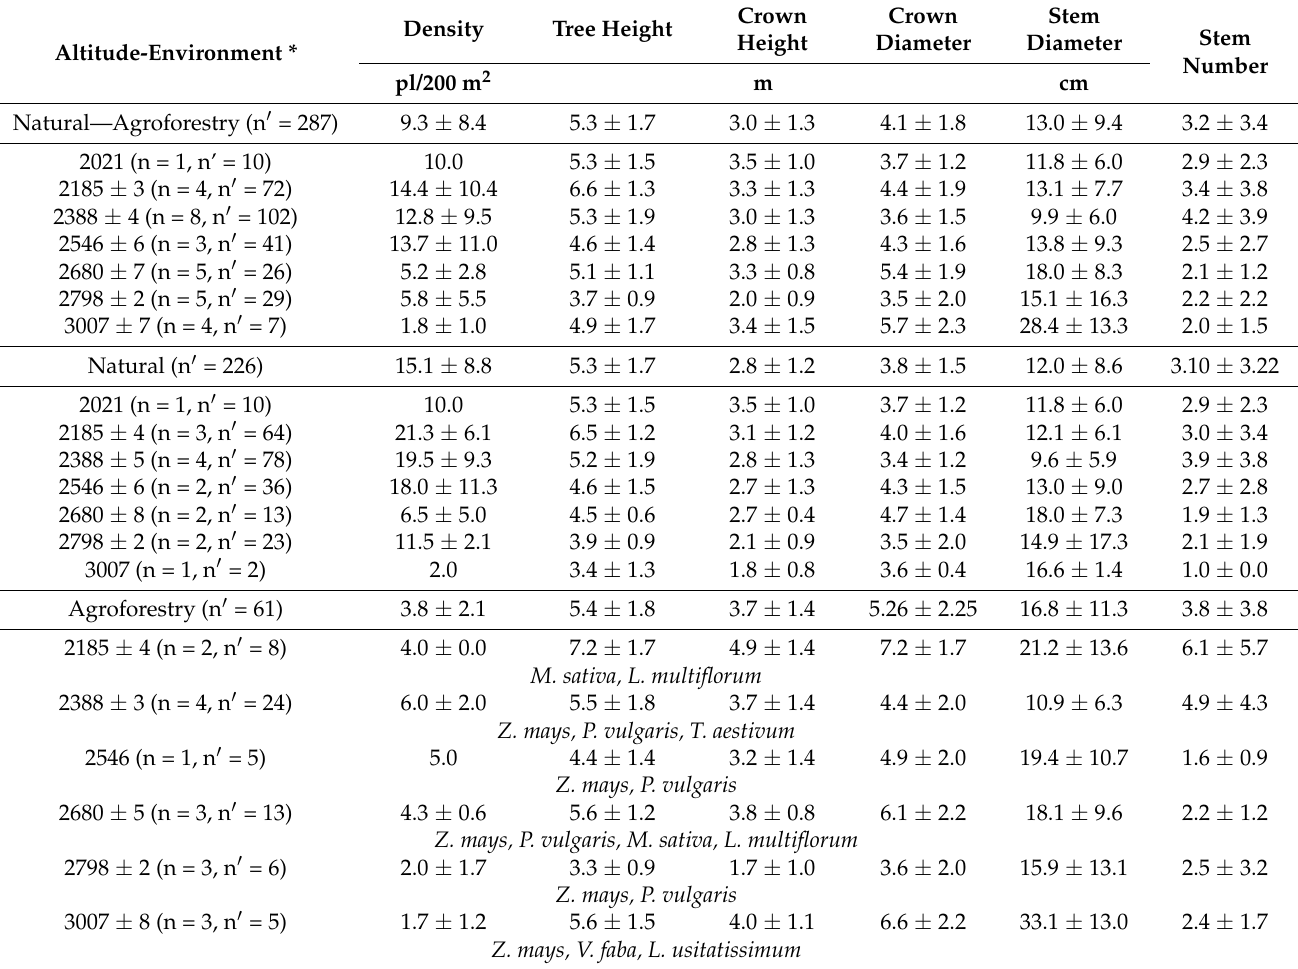
Table 4. Dendrometric variables of Tara trees in altitude class and natural and agroforestry